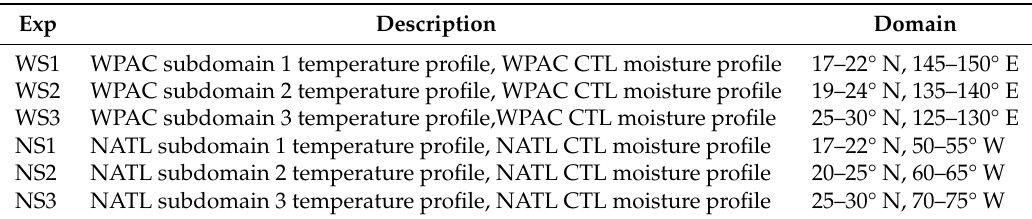
Table 2. Basin subdomains and